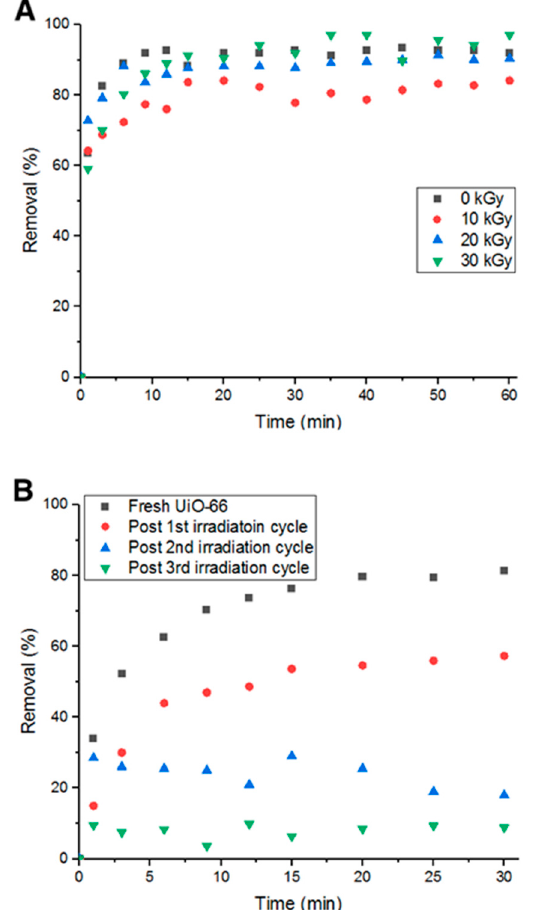
Figure 12. ( A ) Percent removal of Doxycycline with irradiated MOF (different gamma-ray dosages) and ( B ) Percent removal with irradiation cycles .